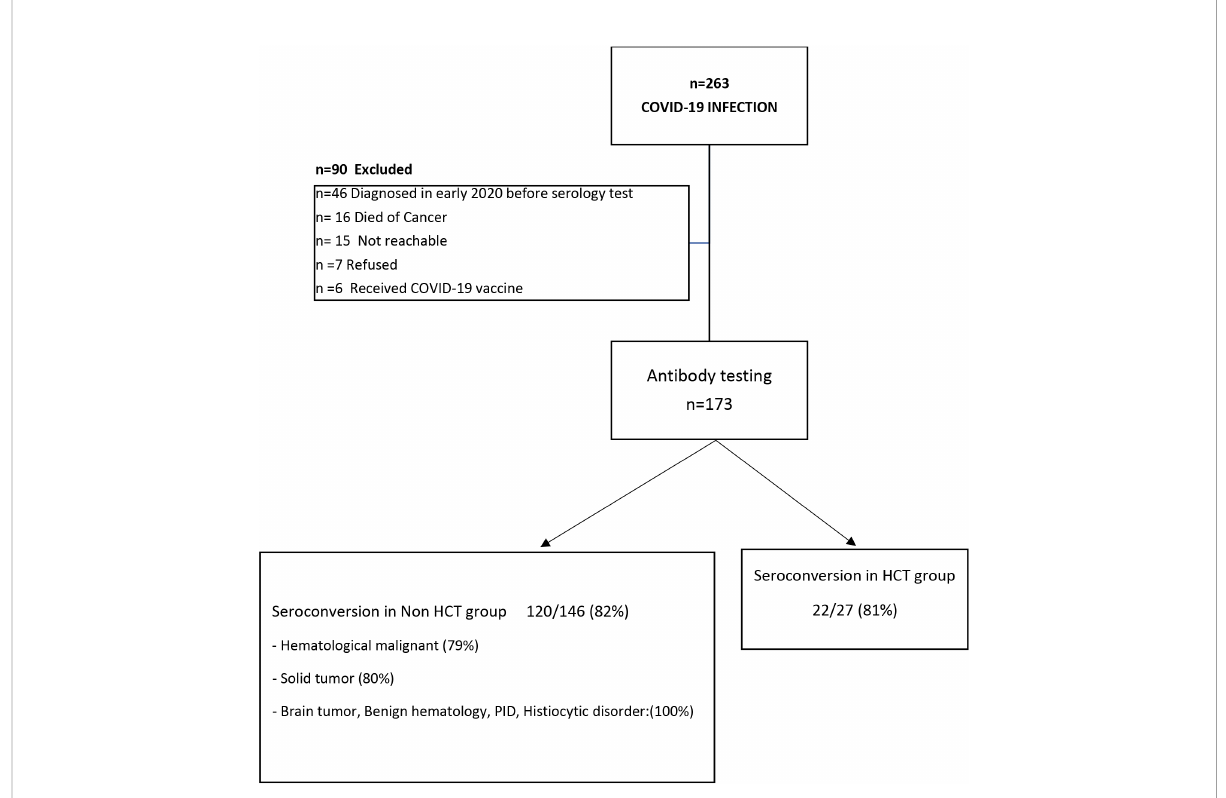
FIGURE 1 Cohort selection and Seroconversion rate post COVID-19 infection: A total of 263 patients with COVID-19 infection were included in this study; of them 173 patients (65%) underwent serology testing, while 90 patients were excluded. Of the 173 patients tested, 142 patients (82%) seroconverted/had a positive Anti-SARS-CoV-2 S antibody; seroconversion rate in patients underwent hematopoietic stem cell transplant (HCT) is 81%, while in non-HCT group is